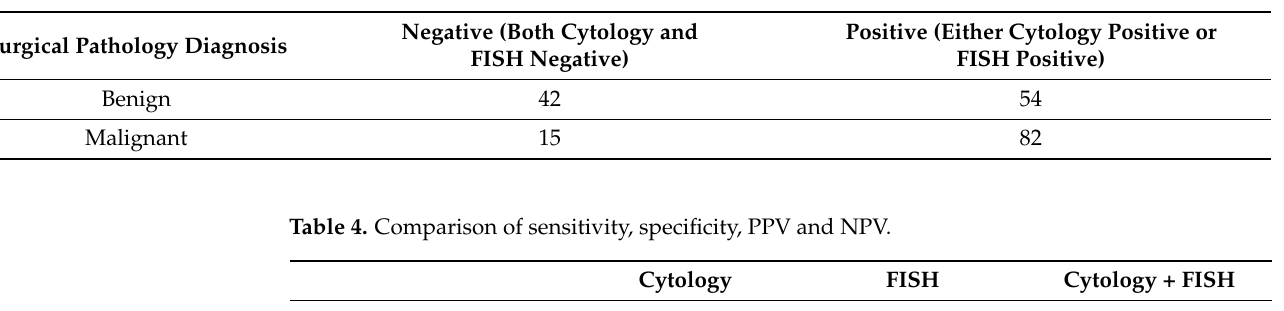
Table 3. Correlation of combined cytology with addition of FISH and final surgical pathology diagnoses.